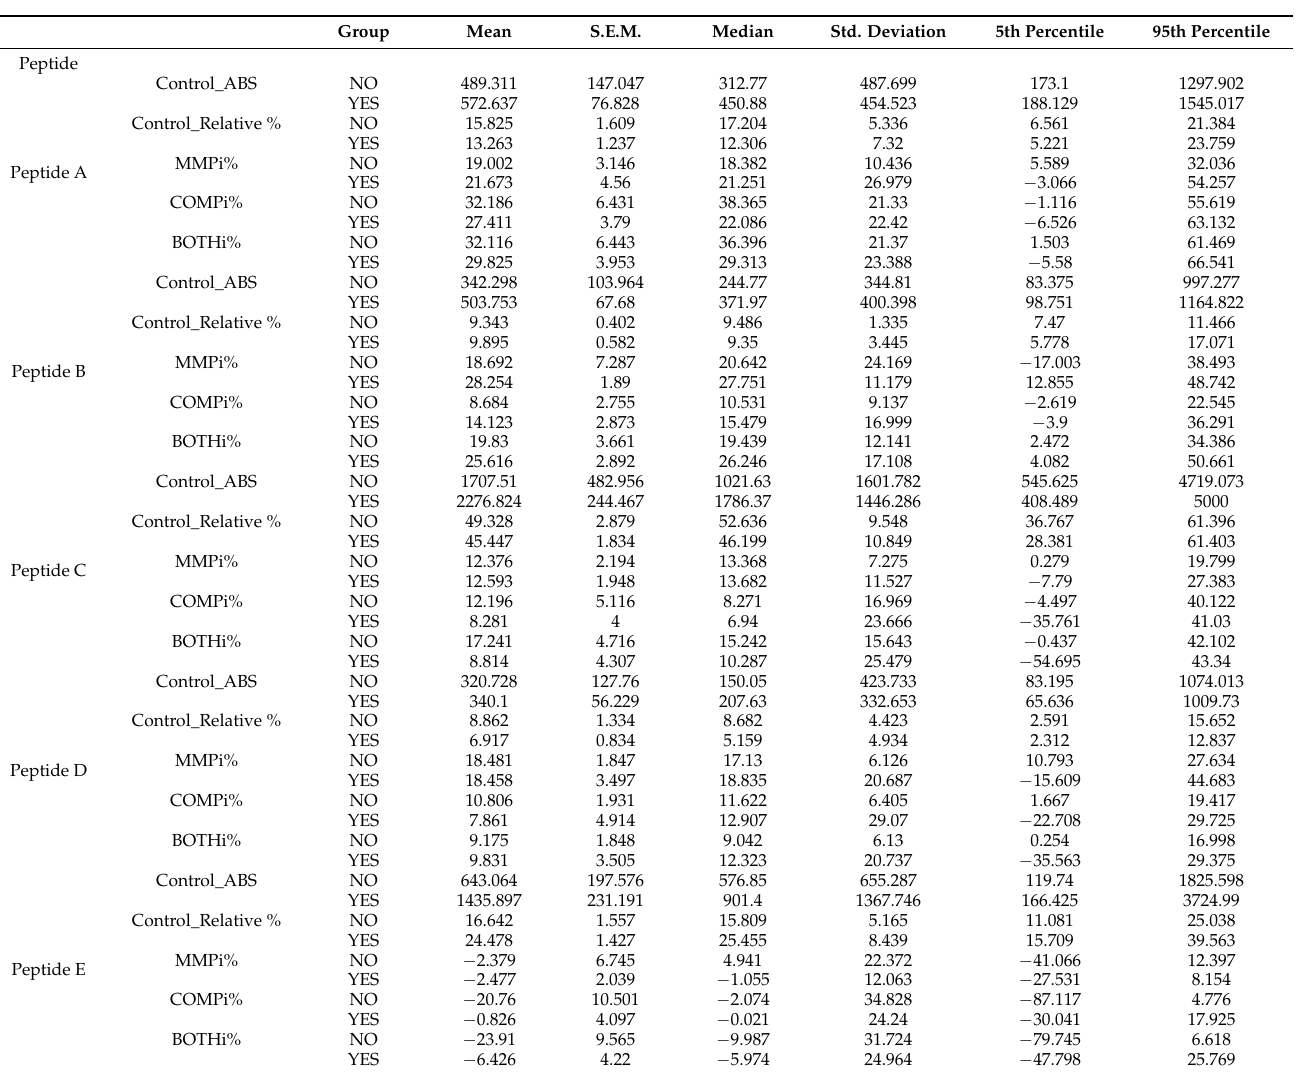
Table A1 summarizes the detailed cleavage data of all samples investigated. Table A1. Proteolytic profiles of saliva samples for peptides A–E for non-inhibited (Control) or inhibitors (_MMPi_, _COMPi_ or _BOTHi_) samples, expressed as absolute (ABS) or relative percentage values to parent activities (_rel%), delineated by caries status (YES/NO). For the cleavage rate analysis, statistical significance was determined using a Shapiro-Wilk test with a threshold for significance determined at p = 0.05. Values are denoted as not